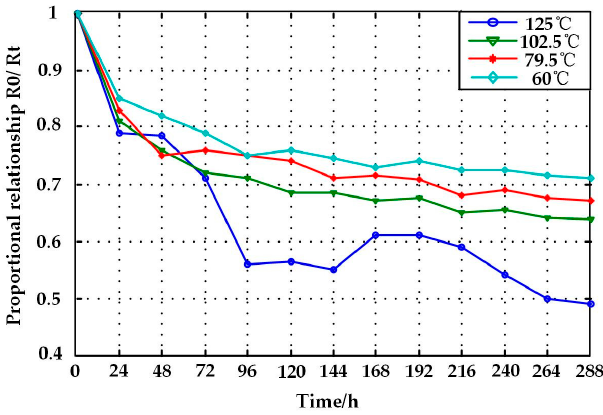
Figure 8. The test values of contact resistance.